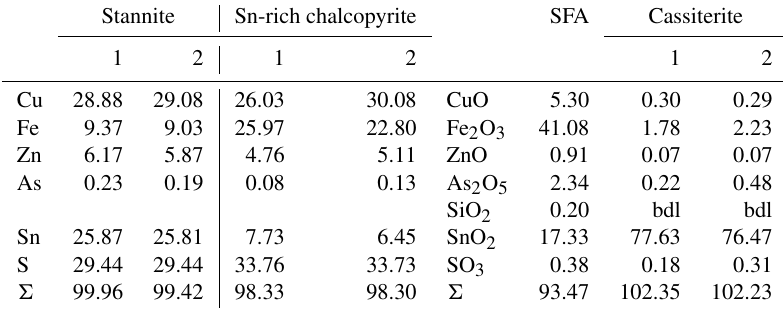
Figure 4. Box plot of the compositional range of SFA precipitates from Giftkies ( n = 221) and Kaˇnk ( n = 109) (average: solid line; median: dashed line; box: 25th–75th percentile; range: minimum–maximum (includes outliers)). Table 3. WDX analyses of primary sulfides and secondary precipitates observed in the stannite grain from Kaˇnk (see Fig. 1b). Values are given in percent by weight (wt%; bdl, below detection limit). Stannite Sn-rich chalcopyrite SFA